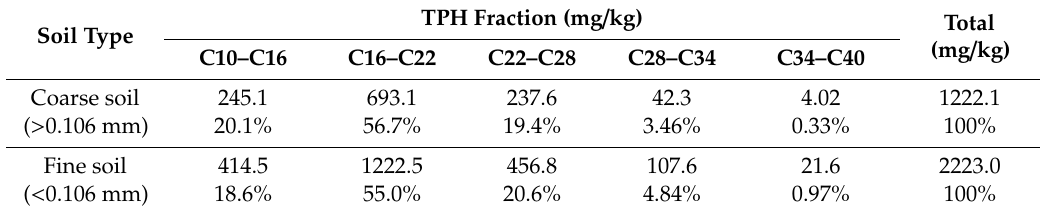
Table 4. Distribution of TPH on different particle soil types as TPH fractions after contamination procedure.